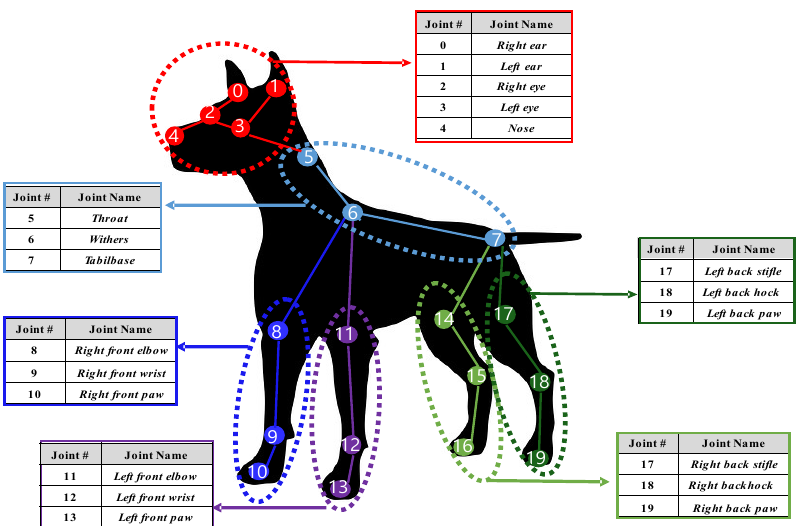
Figure 4. Configuration of the companion dog parts. Table 2. Definitions of categories in dog behavior.